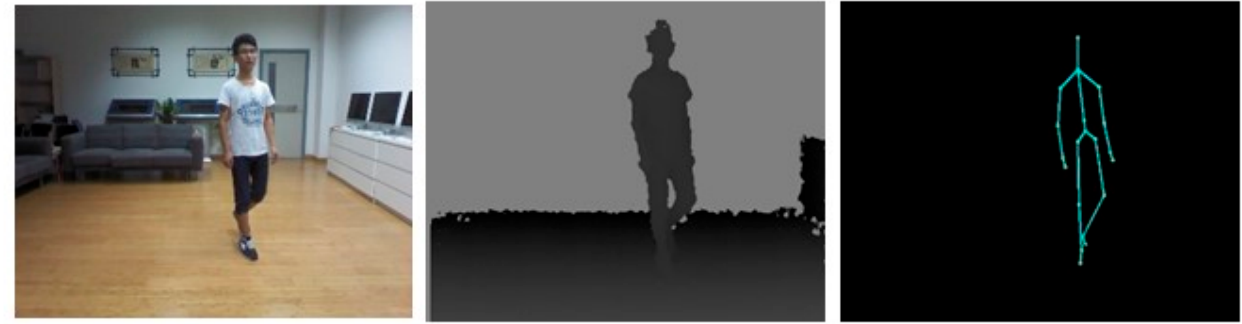
Figure 2. Sample images showing the RGB, depth, and skeleton information of an individual in the RobotPKU RGBD-ID [33] dataset.